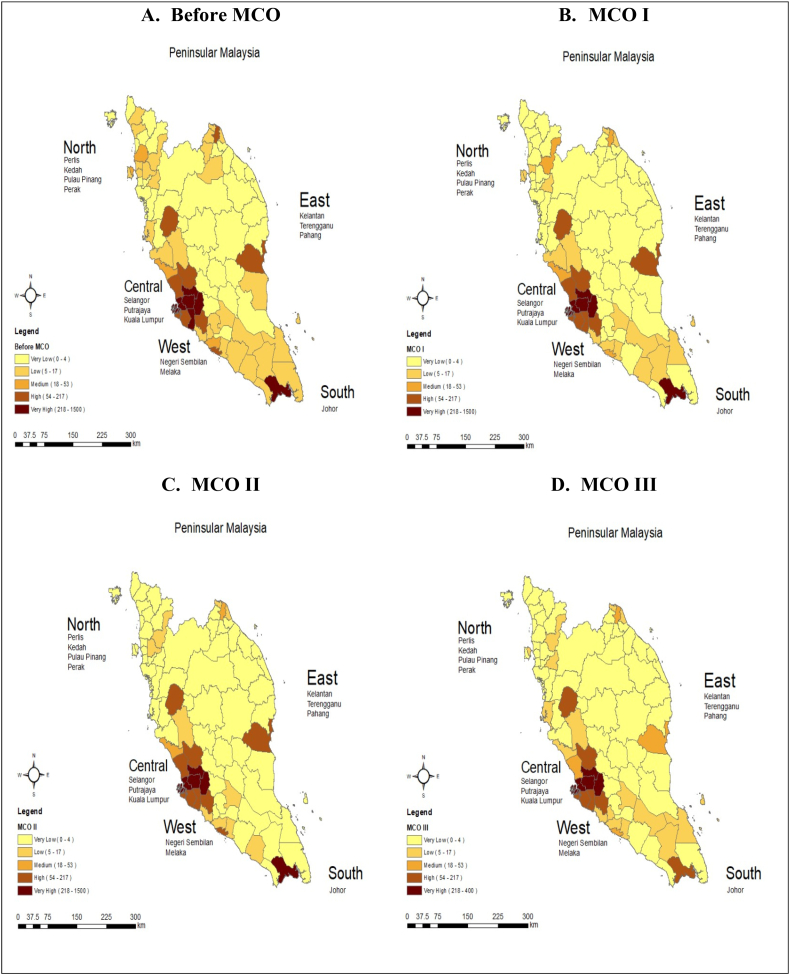
Spatial mapping of distribution pattern of dengue fever cases during MCO phases at district level. There are four phases of MCOs; Phase I (Before MCO: 2nd March to 17th March 2020); Phase II (MCO I: 18th March to 31st March 2020); Phase III (MCO II: 1st April 2020 to 14th April 2020), Phase IV(MCO III: 15th April to 28th April 2020) The data included is the number of dengue cases reported for each district in Peninsular Malaysia.